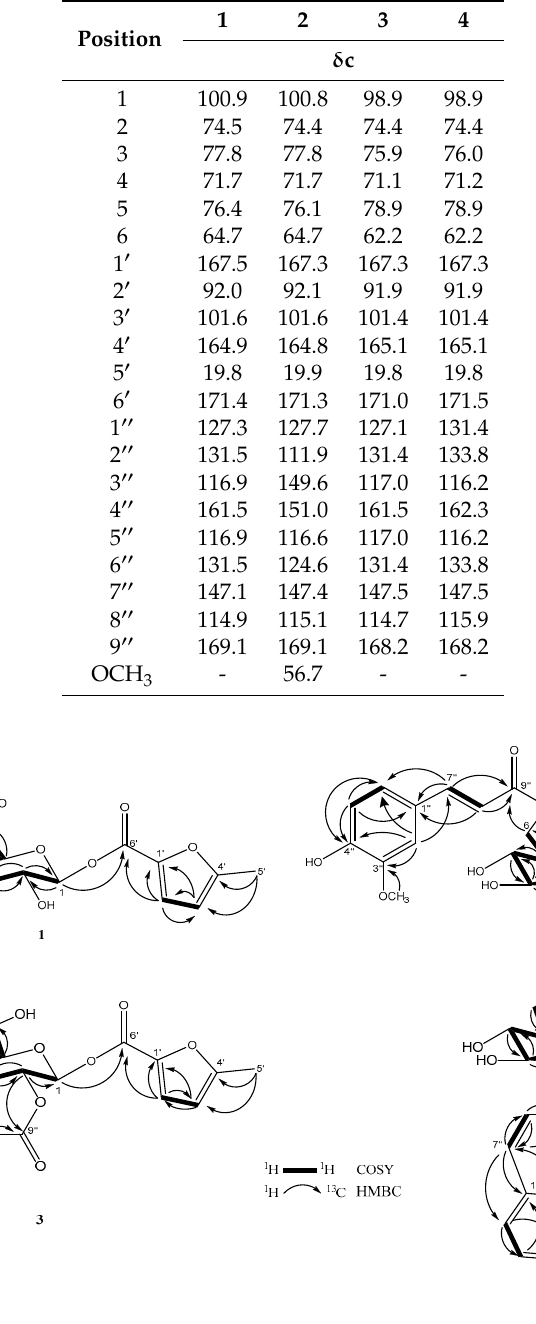
Table 2. 13 C-NMR (125 MHz) spectroscopic data for 1 – 4 in CD 3 OD.